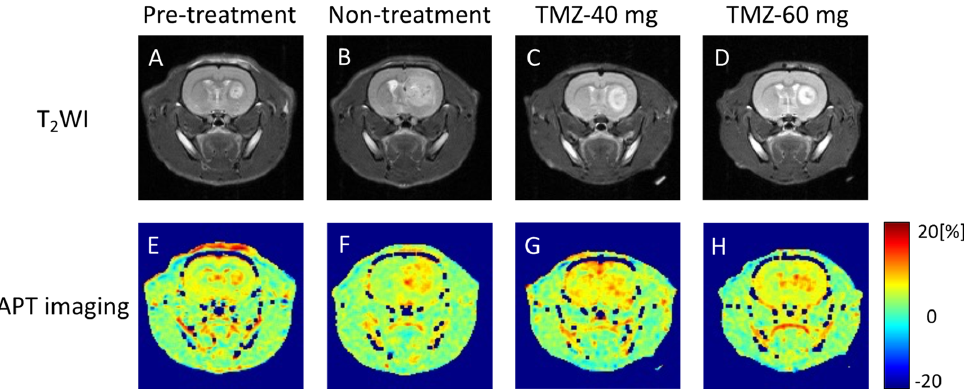
Figure 4. Representative T 2 W and APT images of pre-treatment group ( A , E ) on day 7 after trans- plantation and non-treatment group ( B , F ), TMZ-40 mg ( C , G ), and TMZ-60 mg ( D , H ) on day 14 after transplantation. TMZ, temozolomide; APT, amide proton transfer.